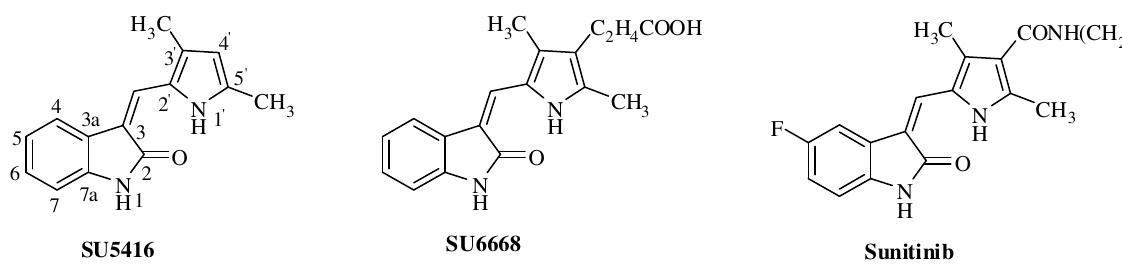
Figure 1. Structures of SU5416, SU6668 and